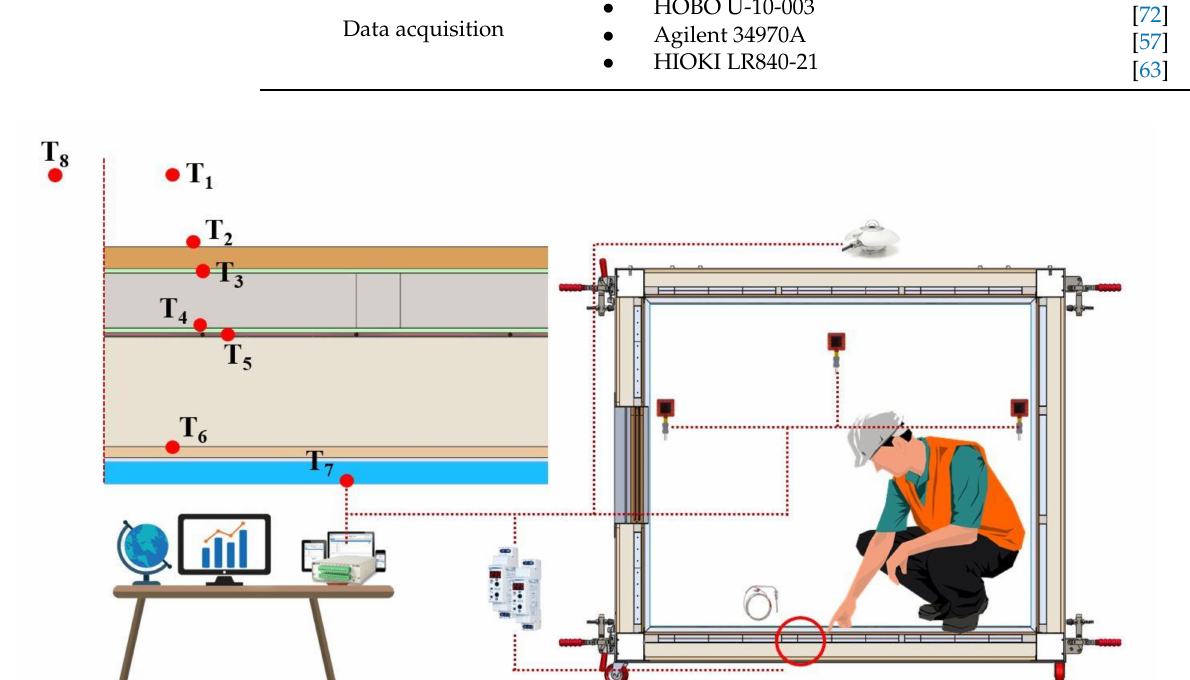
Figure 29. Schematic diagram showing the locations of different sensing instruments (heat flux meters, thermocouples, pyranometer, and data acquisition tool with a computer) for underfloor heating with PCM using ThermoGreen ®